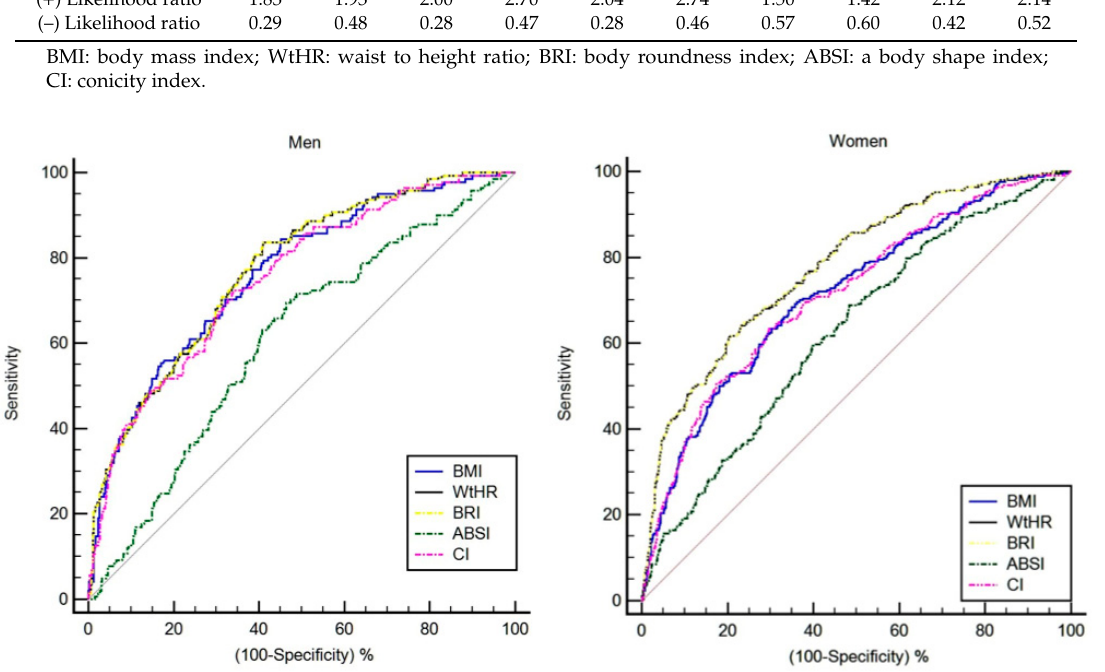
Figure 2. Diagnostic performance of surrogate anthropometric indices to detect high risk of CMRI by gender. BMI: body mass index; WtHR: waist-to-height ratio; BRI: body roundness index; ABSI: a body shape index; CI: conicity index.